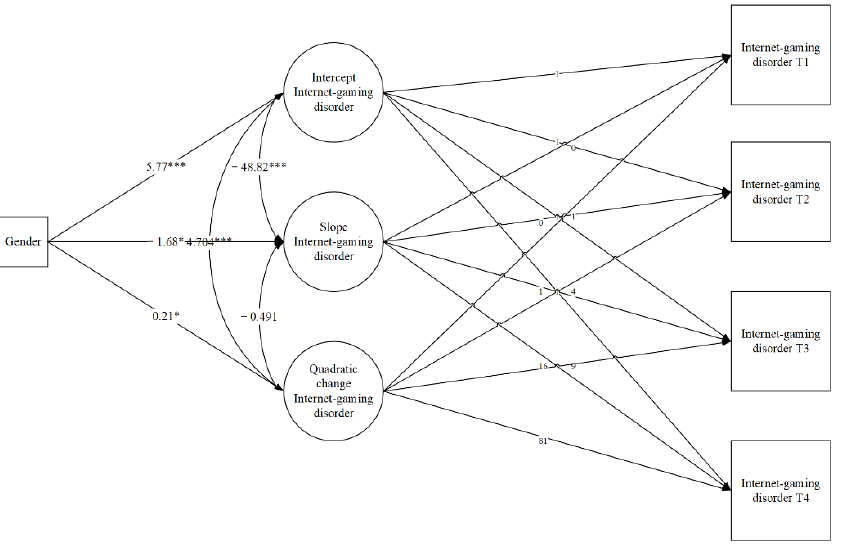
Figure 2. Quadratic LGMs with a time-invariant covariate. * p < 0.05, *** p < 0.001.